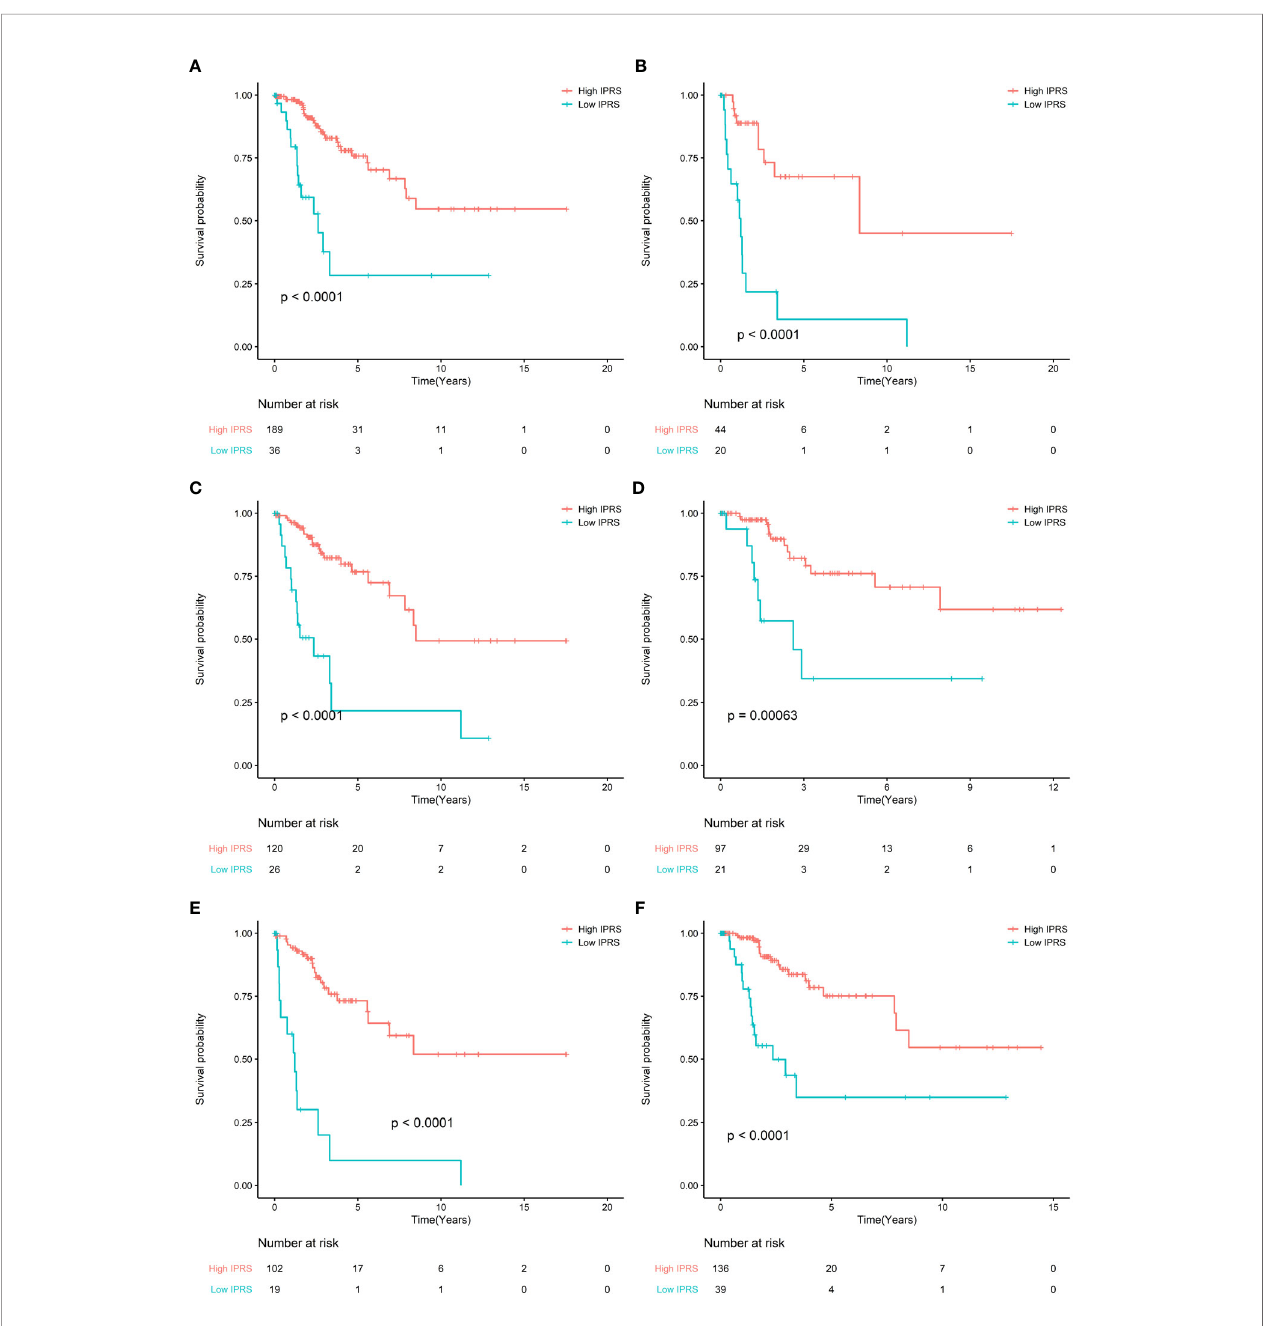
FIGURE 3 | (A) Survival curve of OS between high IRPS and low IRPS in stage I and stage II patients; (B) Survival curve of OS between high IRPS and low IRPS in stage III and stage IV patients. (C) Survival curve of OS between high IRPS and low IRPS in Grade I and Grade II patients; (D) Survival curve of OS between high IRPS and low IRPS in Grade III and Grade IV patients. (E) Survival curve of OS between high IRPS and low IRPS in patients aged ≤ 50 years; (F) Survival curve of OS between high IRPS and low IRPS in patients aged ≤ 50